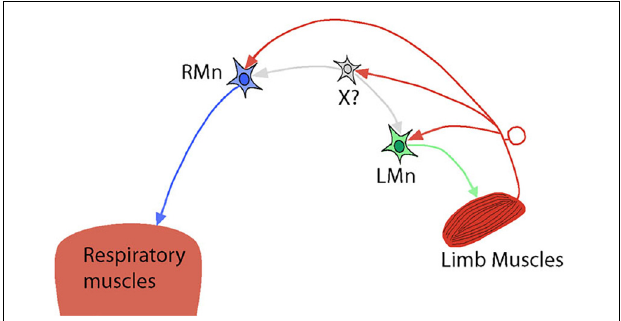
FIGURE 2 | Simplified hypothetical diagram representing intraspinal connections between locomotor and respiratory spinal circuits. RMn – respiratory motoneuron. LMn – limb motoneuron. X? – shared interneuron that drives/modulates both RMn and LMn and receives afferent feedback from limb muscles. Possible direct inputs to RMn from limb muscle afferents are also